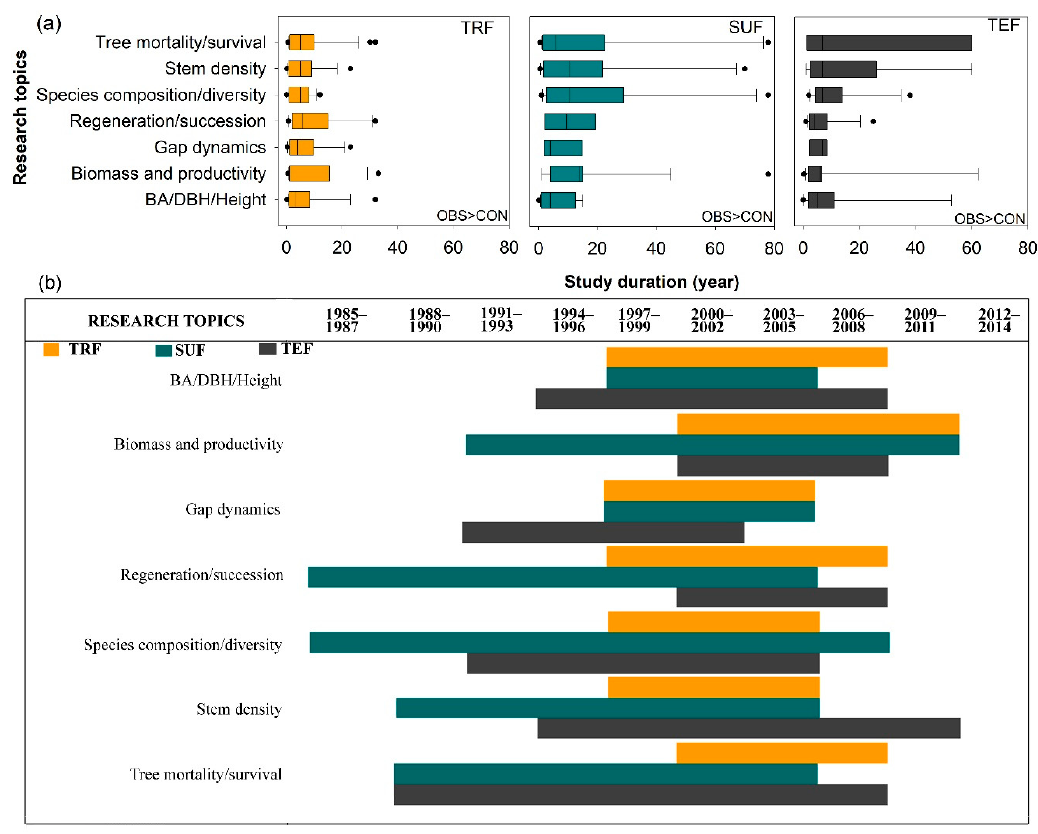
Figure 3. Study duration of the most-studied observational (OBS) and controlled (CON) research topics in TRF, SUF, and TEF: ( a ) descriptive statistics of the length of the study duration (year) and ( b ) time periods using the year data that appears most often in a set of data.